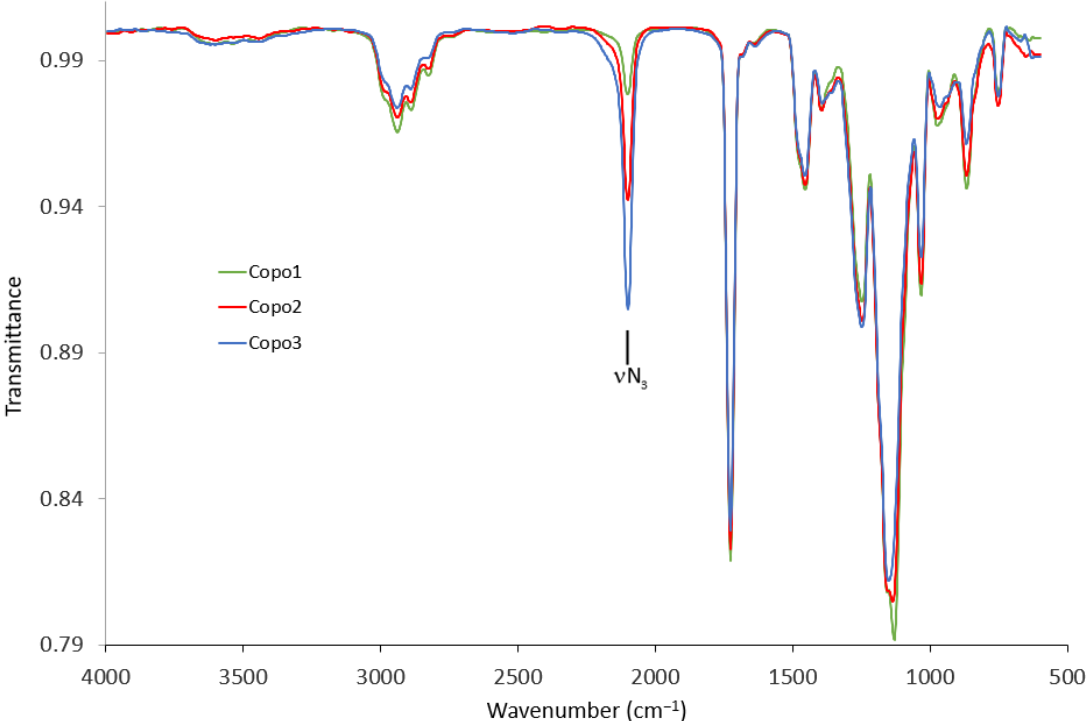
8 of 16 Figure 5. DOSY NMR of copolymers: ( A ) Copo1, ( B ) Copo2 and ( C ) Copo3. 2.4. IR Characterization The chemical composition of the synthesized copolymers was also assessed by FTIR spectroscopy in the range of 4000 to 600 cm −1 (Figure 6). Mainly, the bands at 2950 and 2900 cm −1 were associated with the stretching vibration modes of the CH 2 from aliphatic moieties. A strong azide stretching mode is observed at 2090 cm −1 , and the C = O stretching mode is observed at 1725 cm −1 and C-O at 1130 cm −1 . The intensity of the azide band is